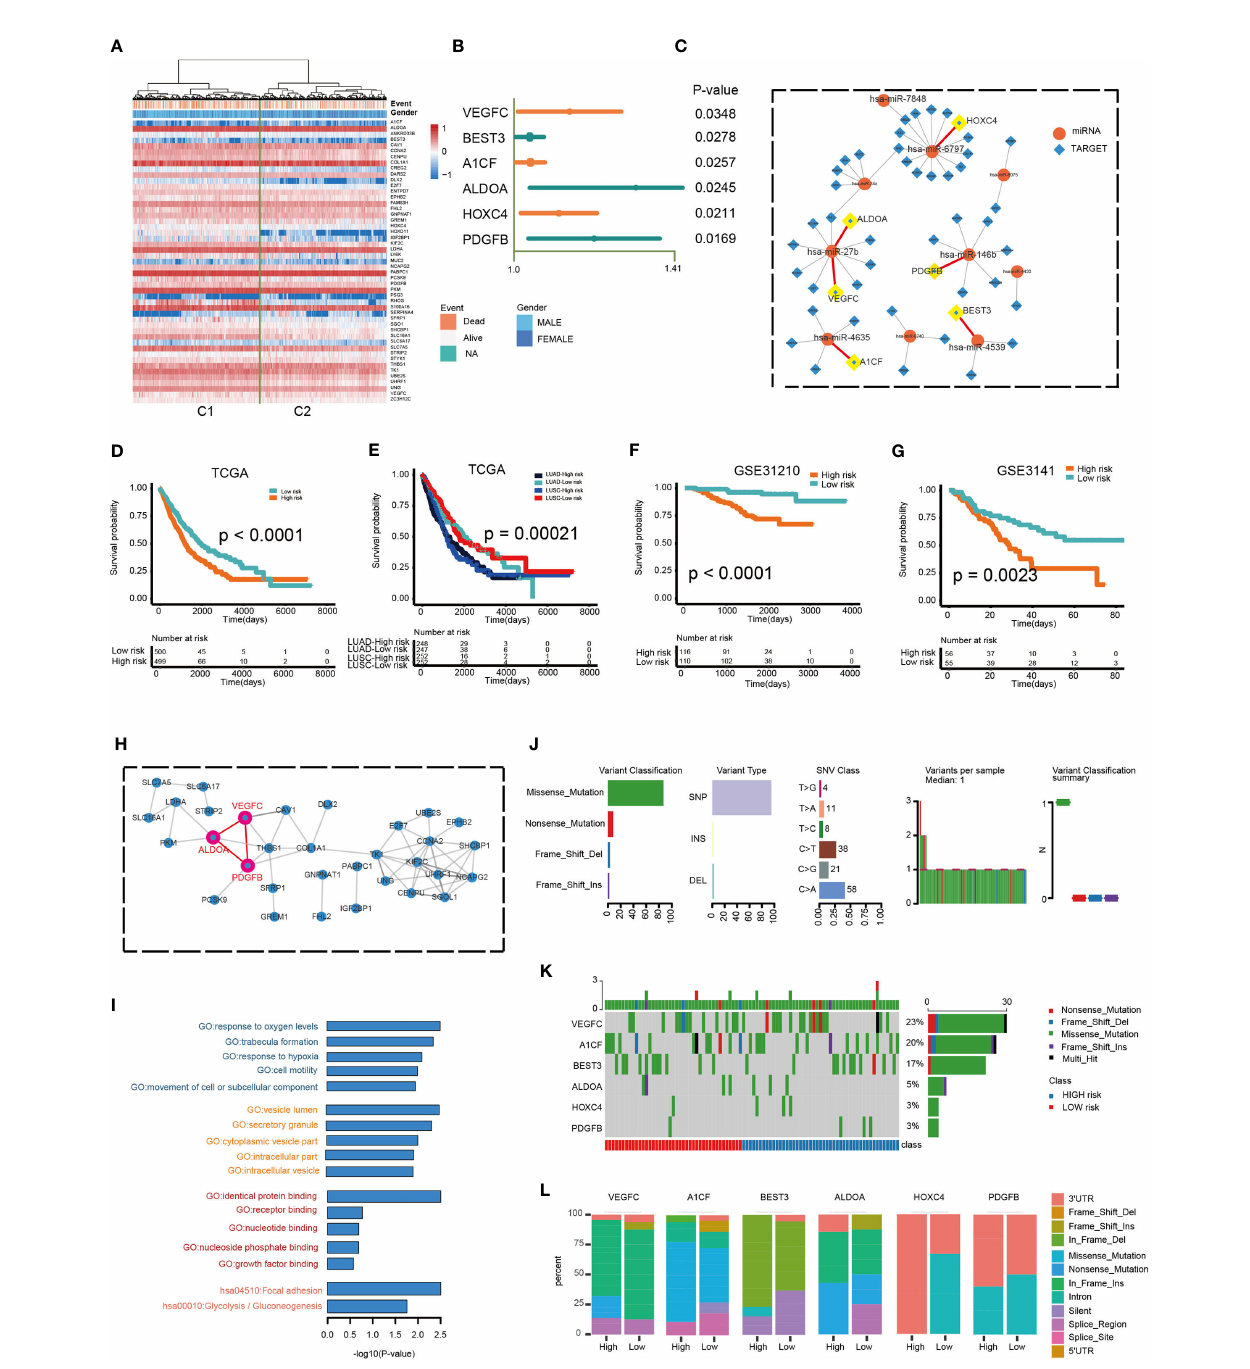
FIGURE 7 | Prognostic potential of a six-gene model. (A) Hierarchical clustering of 1,014 patients from the TCGA cohort using 49 gene expressions. (B) Multivariate Cox regression analysis was used to determine the prognostic values of DEGs. (C) The miRNAs-targets sub-network, includes 49 genes and 10 miRNAs. Circular node denotes miRNAs, square node denotes targets. (D, E) Kaplan – Meier predictions of overall survival in patients of high- or low-risk groups as predicted by the RS module in the validation datasets (TCGA and TCGA LUAD/LUSC). (F, G) Kaplan – Meier approximation of overall survival in patients of high- or low-risk cohorts as predicted by the RS module in the validation dataset (GSE31210 and GSE3141). The log-rank test was used to perform statistical analysis. (H) PPI network. (I) Functional enrichment analysis of GO and KEGG for 49 genes. (J) Mutation features of 6 risk genes and distribution among high- and low-risk groups. (K) The mutation rate of 6 risk genes. (L) The difference of mutation location of 6 risk genes between high and low risk